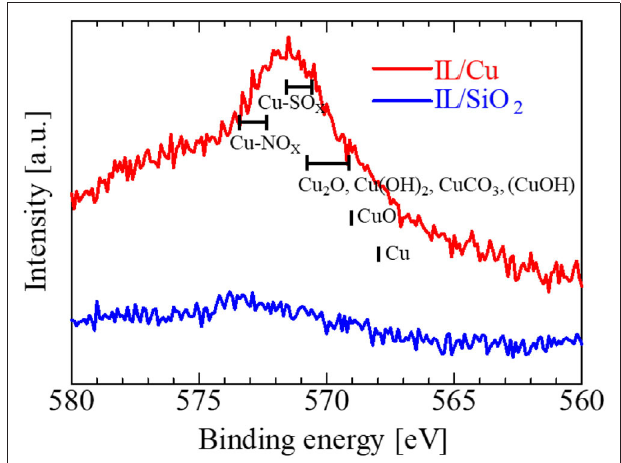
FIGURE 6 | Cu LMM Auger electron spectra for IL/Cu (red) and IL/SiO 2 (blue). The peak positions for some typical Cu compounds are depicted by black bars.